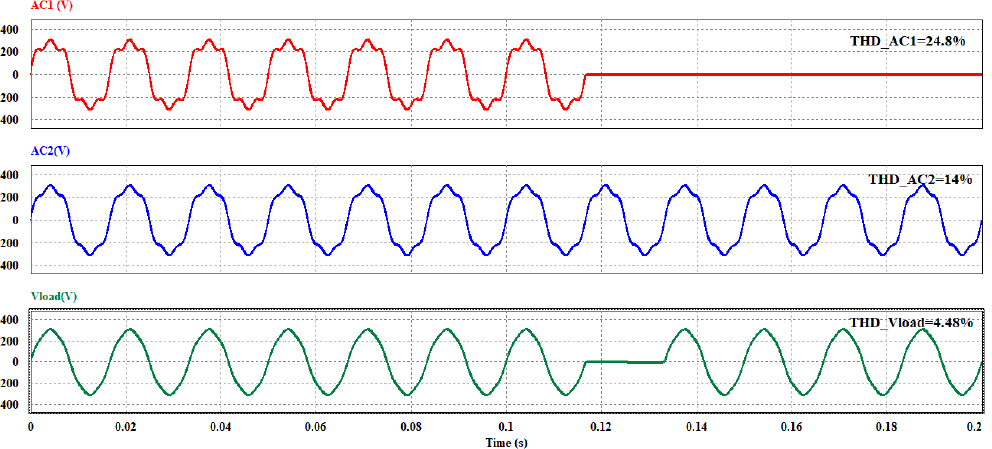
Figure 9. Supply and load voltage waveforms and the transition point of the proposed SSTS when the AC1 and AC2 sources are non-pure sine waves and the AC1 source is faulted at the zero-crossing point (worst case).